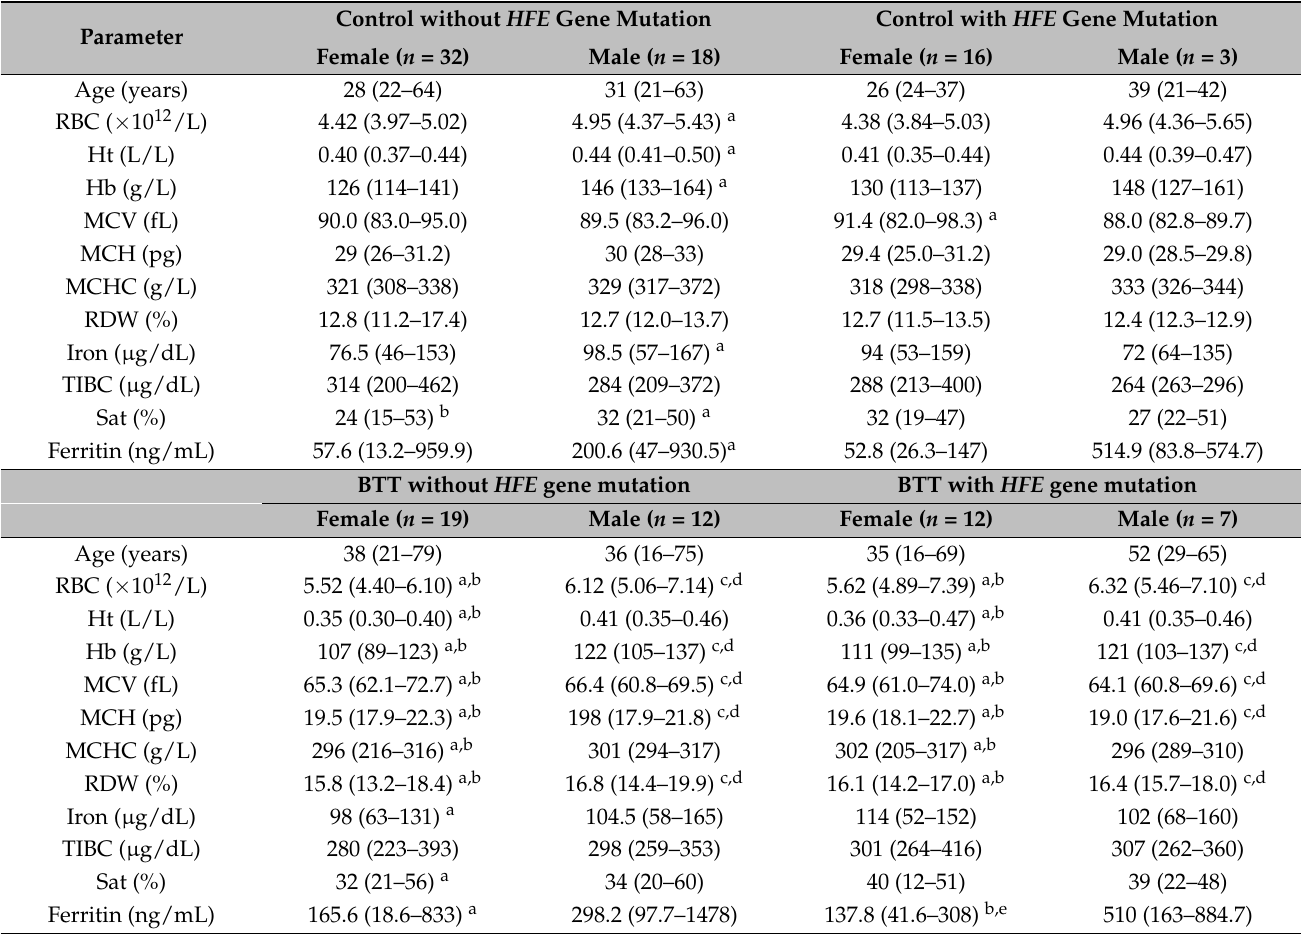
Table 4. Hematological parameters according to HFE gene mutation presence in the study